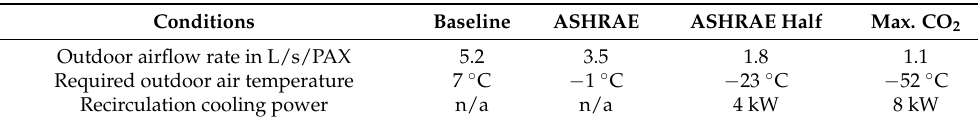
Table 2. Estimated requirement for outdoor air temperature and estimated cooling power required in the recirculation air